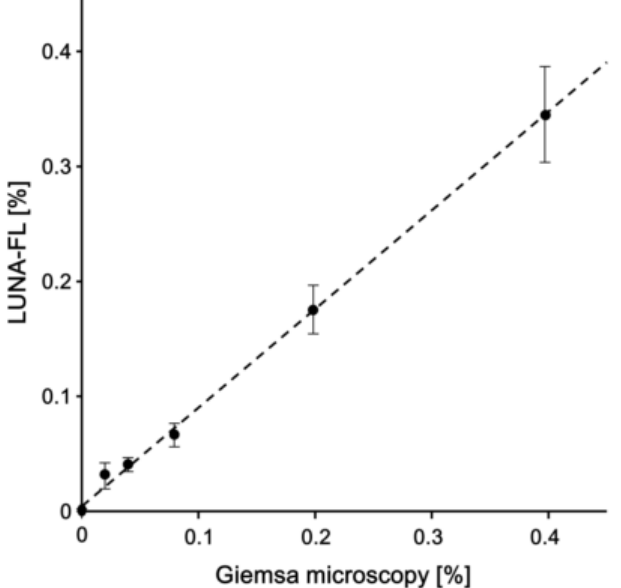
Figure 5. Comparative analysis of the parasitemia estimated with LUNA-FL and Giemsa microscopy. Linear regression analysis was used. Data are expressed as the mean ± SD for five different experiments.